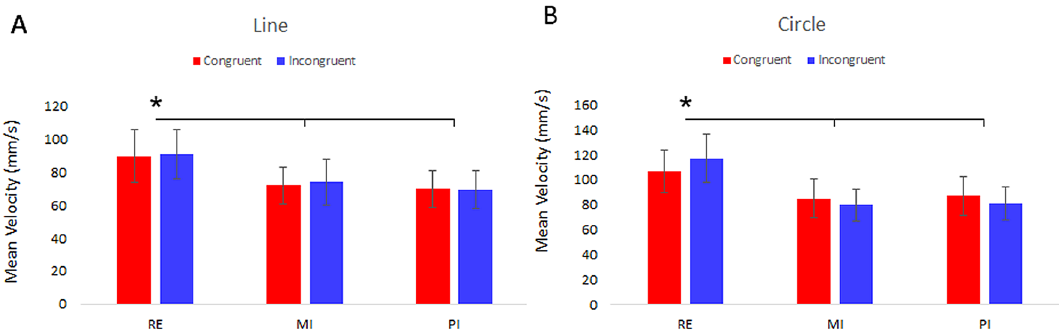
Figure 3. ( A ) Shows averaged Mean Velocity of the line-drawings performed with the left hand in Real, MI and PI protocols in Congruent (red) and Incongruent (blue) conditions. ( B ) Shows averaged Mean Velocity of the circle-drawings in the three protocols and in the Congruent and Incongruent condition. The error bars refer to the standard error of the mean. *Refers to p <